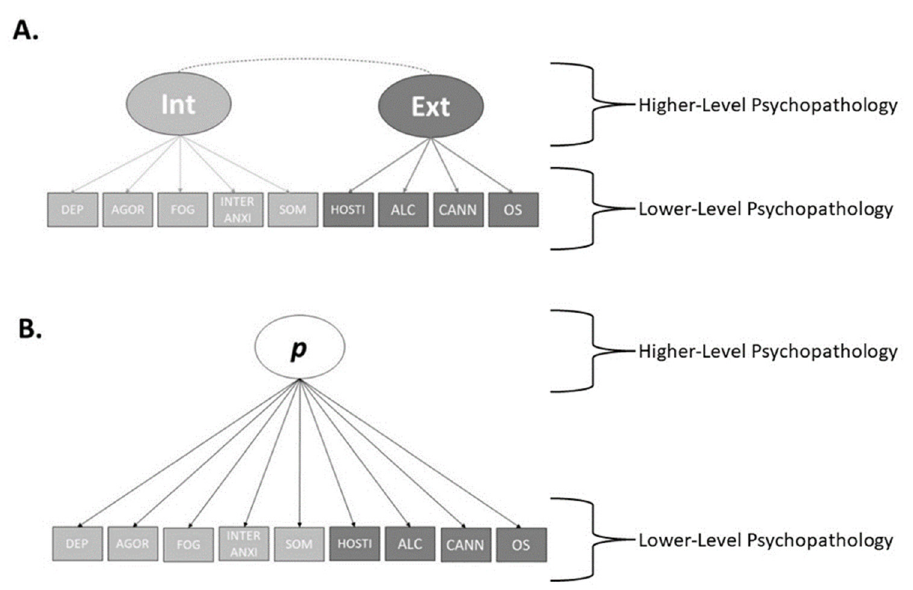
Figure 1. Correlated Factors Model and the Single Factor Model. Note. Adapted from Haywood, Baughman, Mullan and Heslop [23], final structural models of psychopathology used in this re- search. Pictured is the Correlated Factors Model ( A ) and Bifactor Model ( B ). DEP = Depression. AGOR = Agoraphobia, FOG = Mental Fog, INTER ANXI = Interpersonal Anxiety. SOM = Somati- sation, HOSTI = Hostility. ALC = Alcohol. CANN = Cannabis. OS = Other Substances.